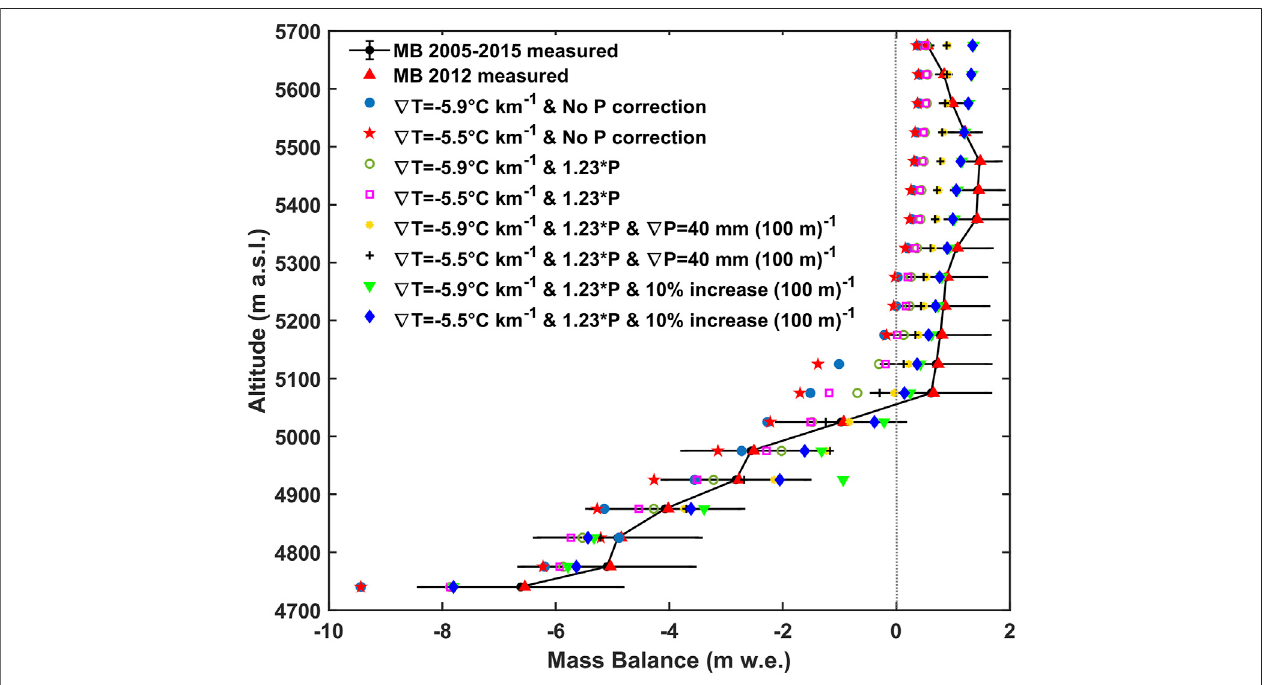
FIGURE 12 | Variation of simulated mass balance 2012 pro fi le to changes in temperature lapse rate and precipitation correction schemes. Scheme with ∇ T (cid:1) − 5 . 5 ° C km − 1 and 10% (100 m) − 1 linear increase of corrected precipitation by 1.23 factor used for simulating distributed SEB got the minimum RMSE.